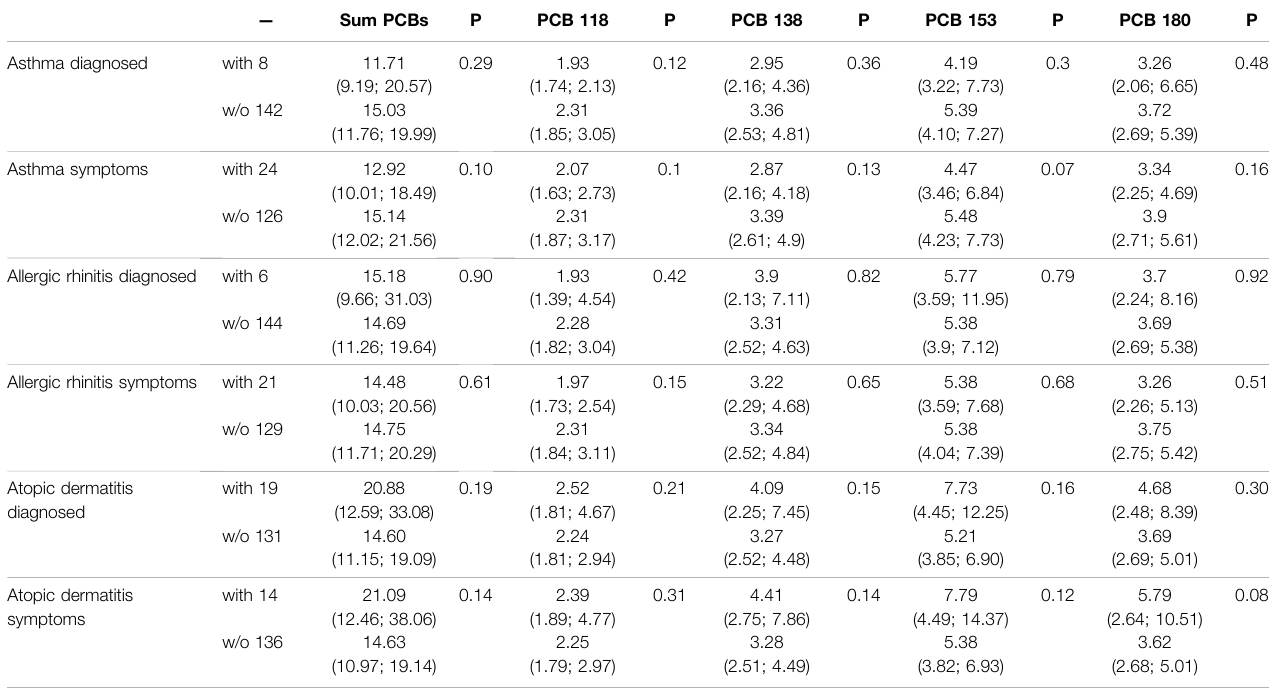
TABLE 3 | Maternal median (IQR) serum PCBs concentration (lipid adjusted) among offspring with or without allergic outcomes.